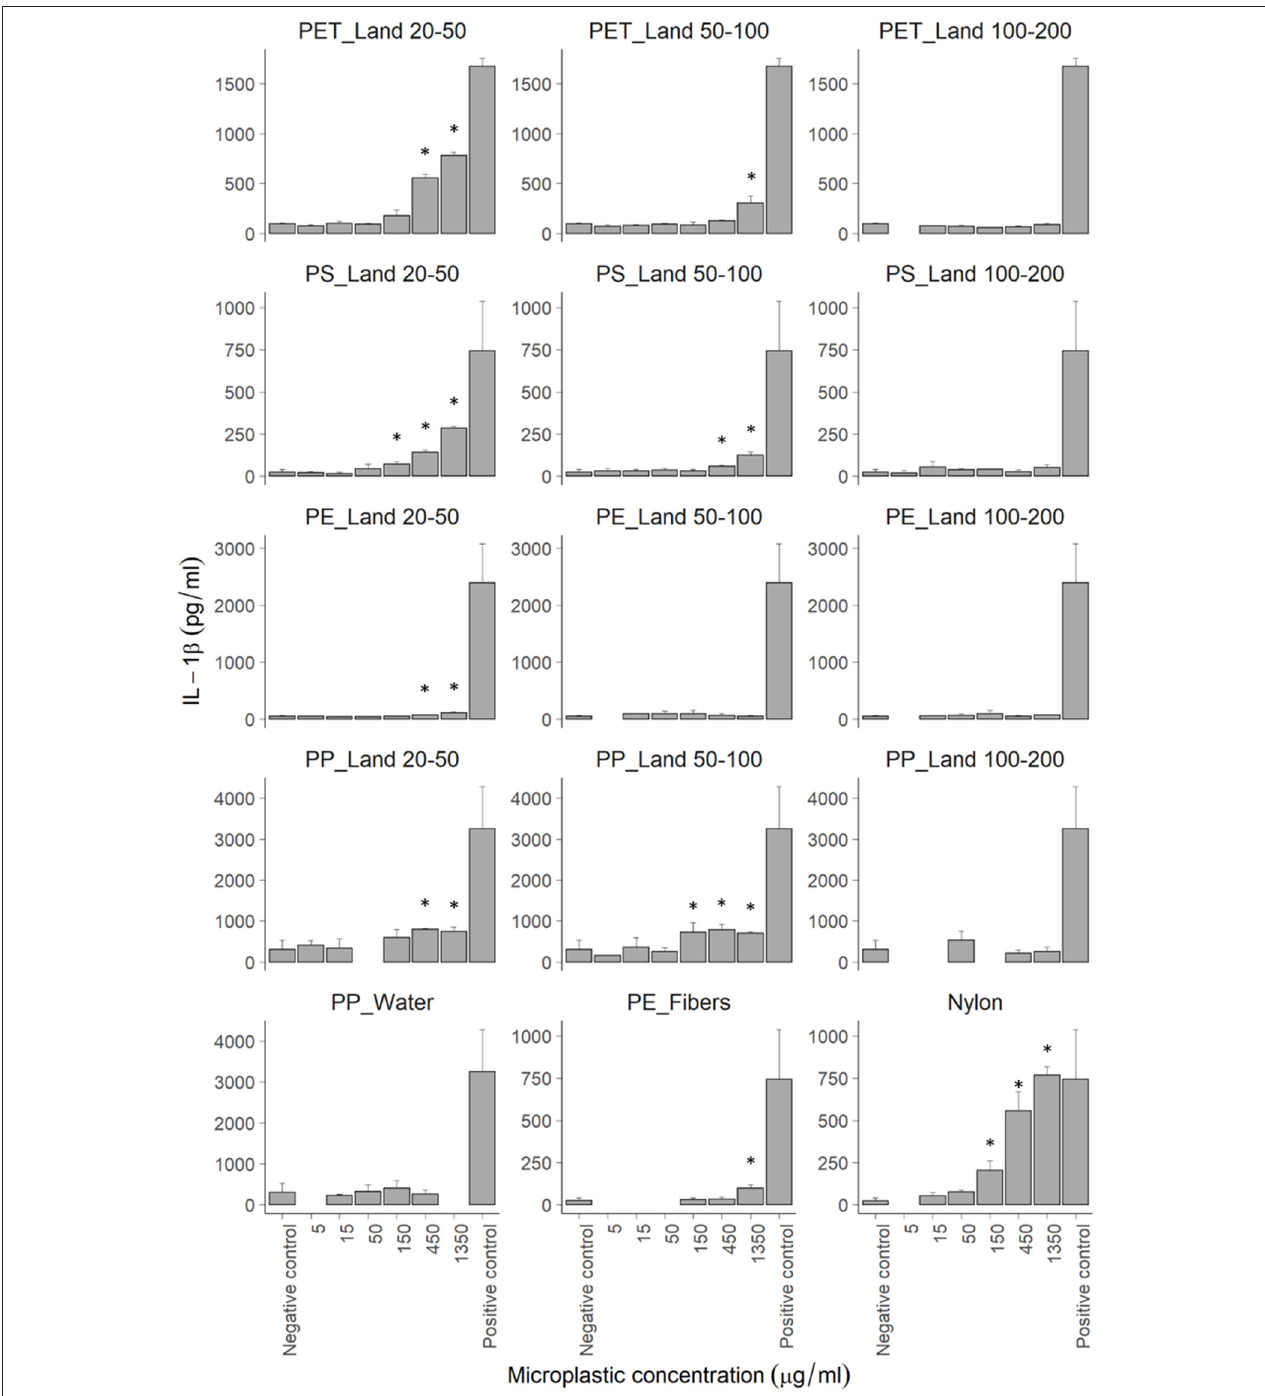
FIGURE 4 | IL-1 β secretion by THP-1 cells after 48h of exposure to various microplastic samples measured by ELISA. Bars represent the mean values (N > 3) with error bars to indicate the confidence interval at 95%. Positive controls were exposed to 1.25 µ M Nigericin. Statistical significance indicated by stars with the following p-values: * P ≤ 0.05 as calculated using Non-parametric Kruskal-Wallis one-way ANOVA’s.